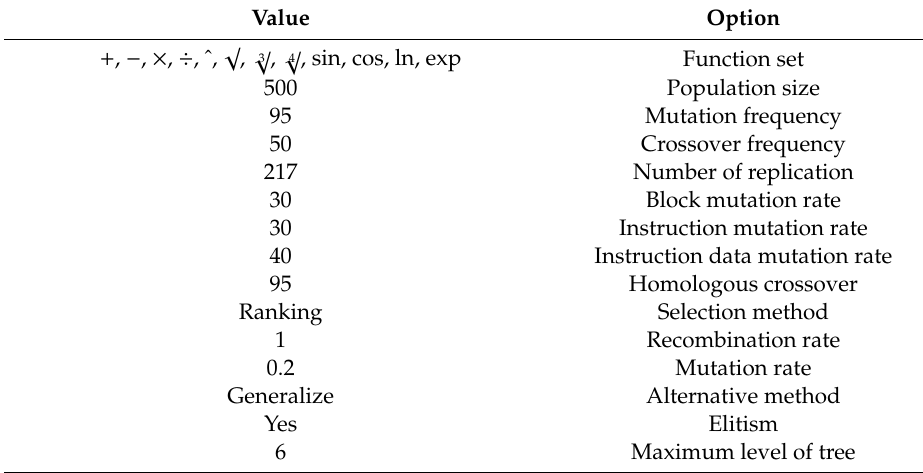
Table 3. Parameters of gene expression programming (GEP) employed in this study by using GeneXpro Tools version 5.0.